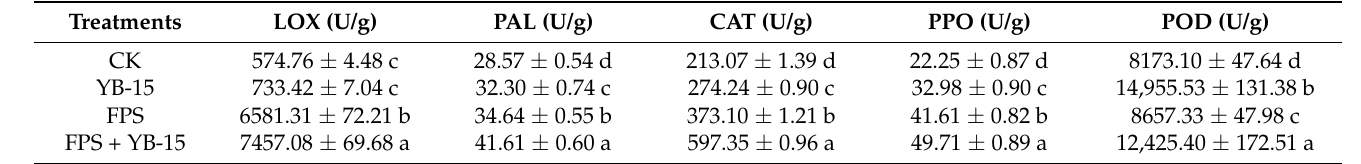
Table 3. Activities of defense-related enzymes in wheat leaves.